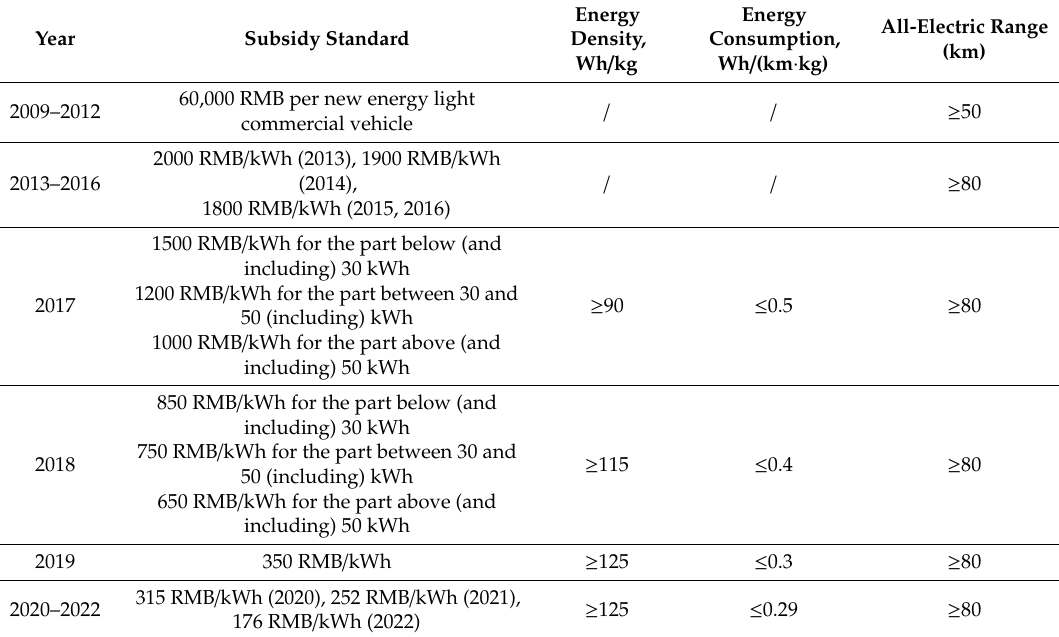
Table 1. The national purchase subsidy standards and technical standards for battery electric logistics vehicles (BELVs) from 2009 to